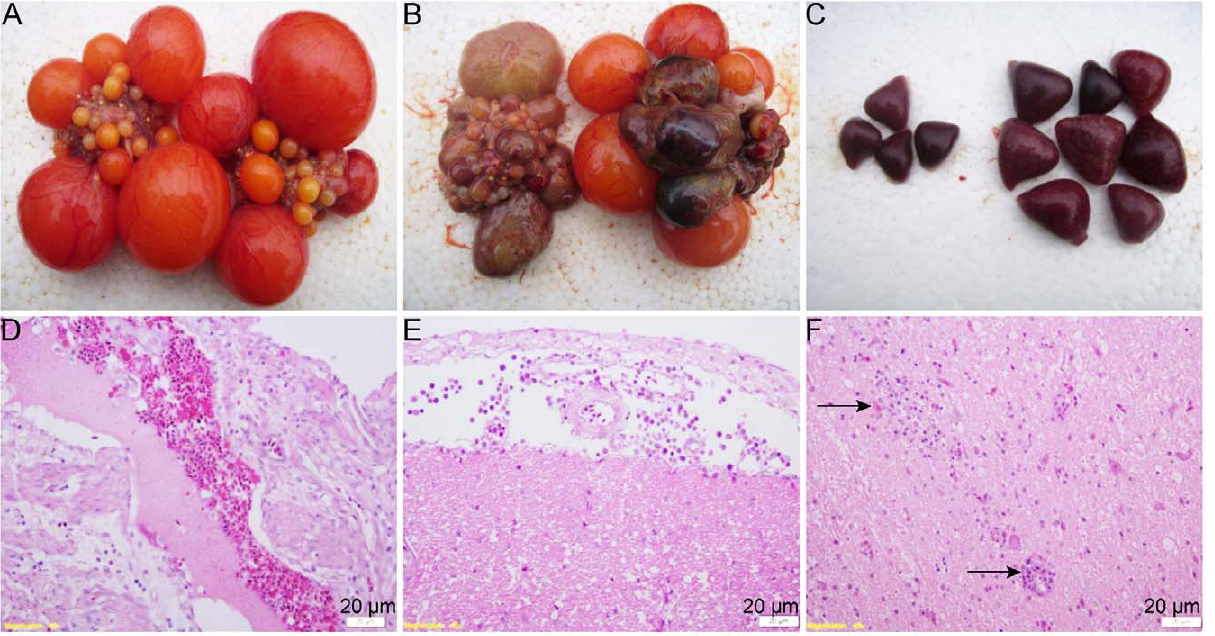
Figure 6. Pathological changes of the experimentally-infected ducks. Mock-infected control (A); Severe hemorrhage and regression of ovarian follicles (B); Spleens from mock-infected control (left) and enlarged spleens from the infected ducks (C); HE-stained ovary section showing hemorrhage and follicle rupture with red stained bodies (D); HE-stained brain section revealing lymphocytes and mononuclear cell infiltration under cranial arachnoid (E) and focal gliosis (arrow) (F).